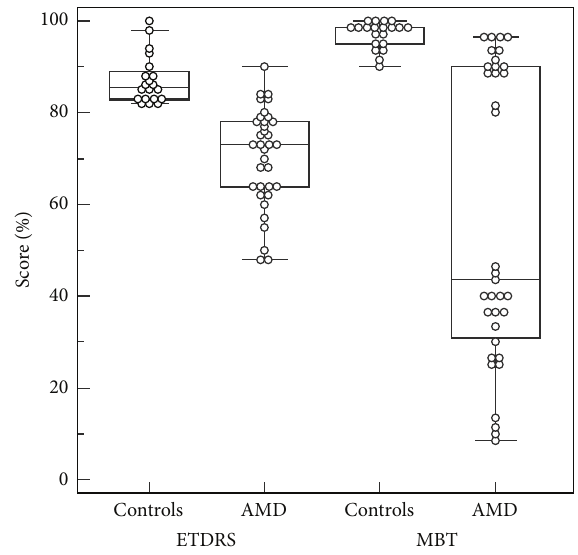
Figure 2: Box-and-whisker plots of ETDRS and MBT results at study